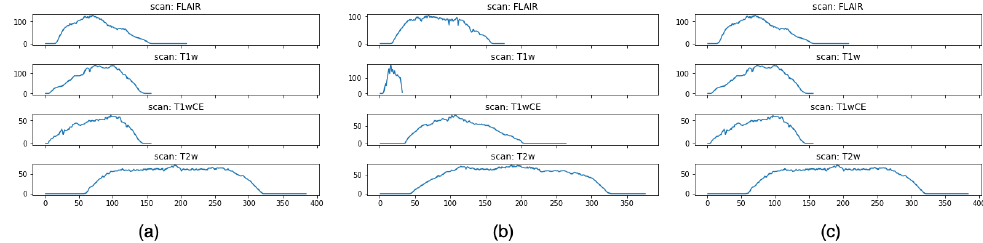
Figure 3. Intensity visualization. Subfigures ( a – c ) represent the intensity charts of the four modalities for three randomly selected samples.